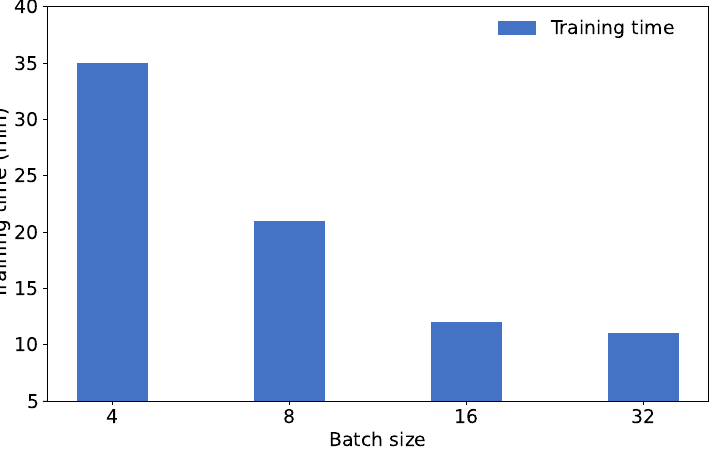
Figure 9. The training time (minutes) per epoch on Titan RTX based on different batch